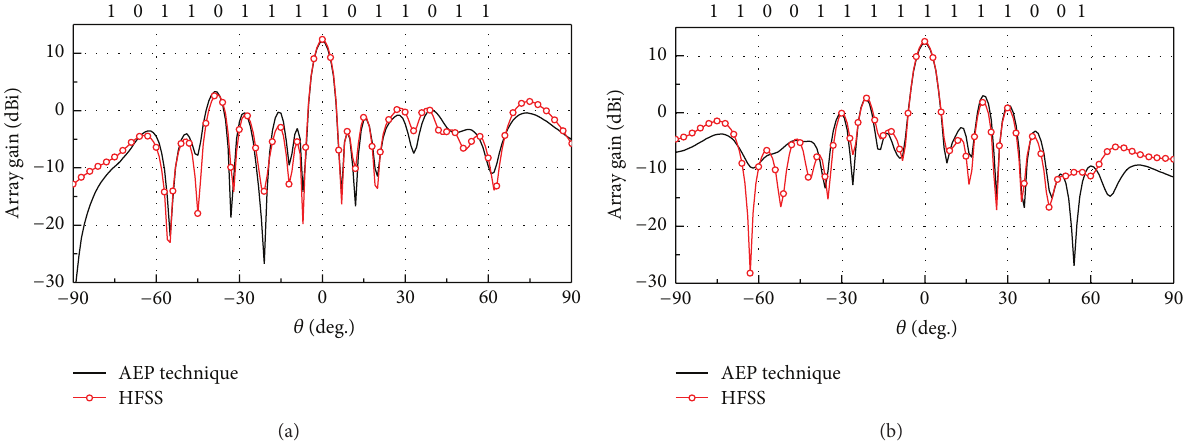
Figure 6: Gain patterns of conformal thinned arrays. (a) Thinned array 1. (b) Thinned array